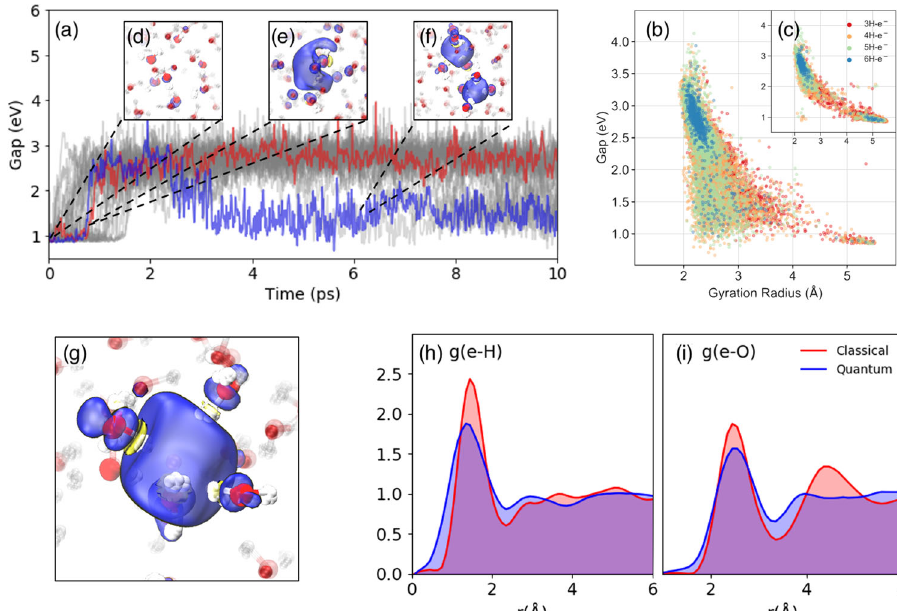
Fig. 1 Computed properties of the solvated electron. a Time evolution of the energy gap of the excess electron as obtained from 30 individual trajectories, with two representative curves marked in red (single-cavity) and blue (involving a twin cavity). b Band gaps, gyration radii of the spin density distribution with different H-e − coordinations, as obtained from quantum and c classical simulations. The coordination number between e − and hydrogen are marked in red (3H-e − ), orange (4H-e − ), green (5H-e − ), and blue (6H-e − ). Spin densities of the solvated electron from quantum dynamics are shown for d the delocalized electron, e the pre-solvated electron, f a twin cavity, and g a single cavity. The yellow isosurface indicates a negative ρ spin ( r ). h , i Radial distribution functions of hydrogen ( h ) and oxygen ( i ) atoms with respect to the center of the solvated electron spin density distribution from classical (red) and quantum (blue)